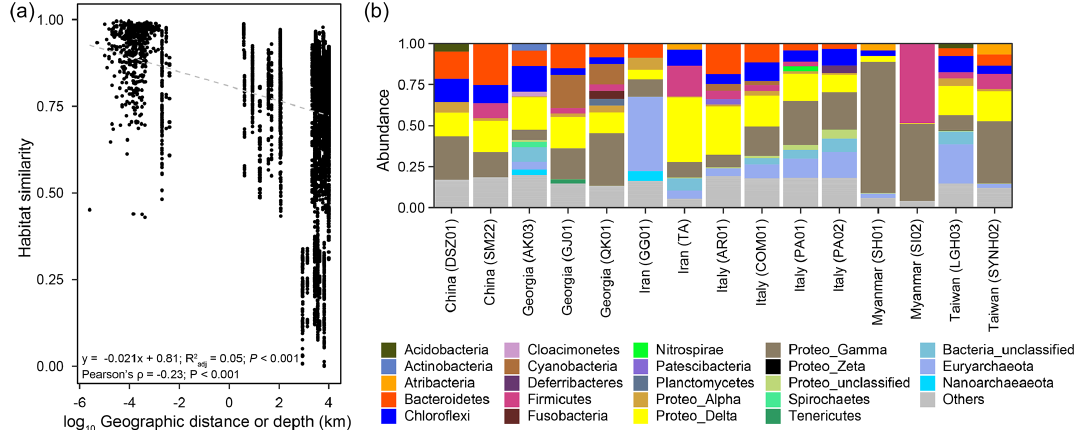
Figure 2. (a) Plot of habitat similarity versus geographic distance or depth. (b) Abundances of major phyla based on 16S rRNA gene amplicons. Raw sequence data for LGH03 and SYNH02 from Tu et al. (2017) and Lin et al. (2018) were incorporated for the analysis and